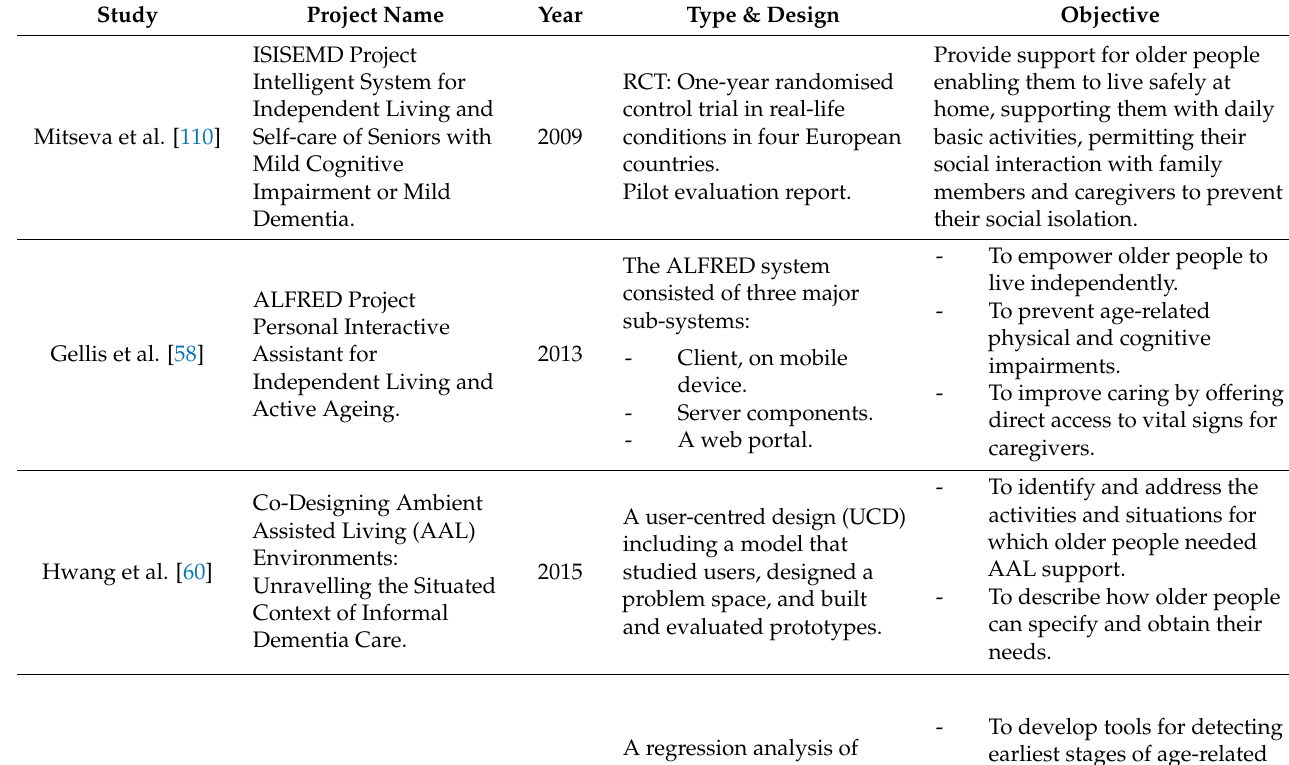
Table 4. ICT solutions for assistive living of older people with cognitive impairment and other